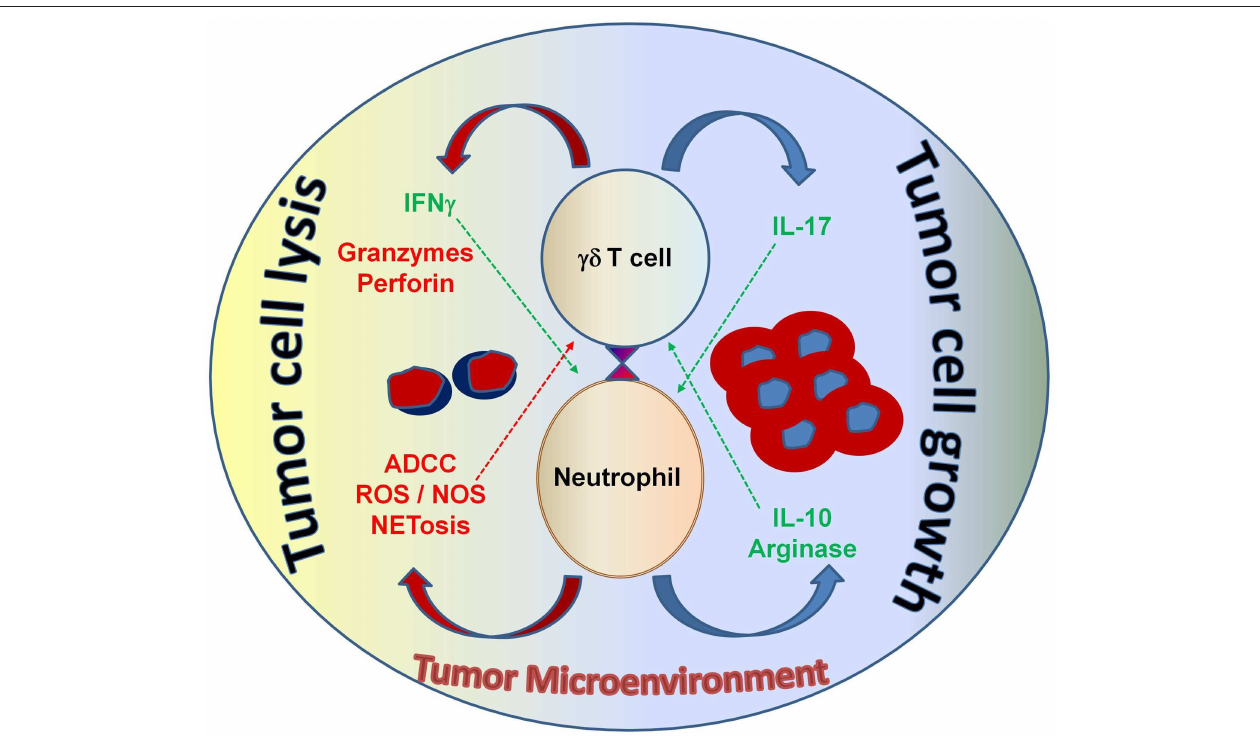
FIGURE 5 | The interaction between neutrophils and γδ T cells can be both pro- and anti-tumorigenic, depending on the tumor microenvironment. Neutrophils can function as myelosuppressive cells and release factors, such as arginase and IL-10 that work to suppress anti-tumor immune effector functions. Alternatively, neutrophils can directly take on anti-tumor effector functions by releasing noxious substances that kill cancer cells. Both tumor-derived factors and accessory immune cells play a role in modulating neutrophil function in the context of malignancy. γδ T cells that secrete IL-17 promote myelosuppressive cells; whereas, γδ T cells that secrete IFN- γ augment anti-tumor effector functions and display potent cytotoxicity, which is important for tumor cell eradication. Understanding this interplay will help develop strategic therapeutic agents that shape the immune environment to elicit strong anti-cancer effector functions from both neutrophils and γδ T cells—with the goal of improving immunotherapy outcomes for patients with cancer. ADCC, antibody-dependent cellular cytotoxicity; ROS, reactive oxygen species; NOS, nitric oxide species; NETosis, the process of cell death induced by the release of chromatin and granular contents into the extracellular